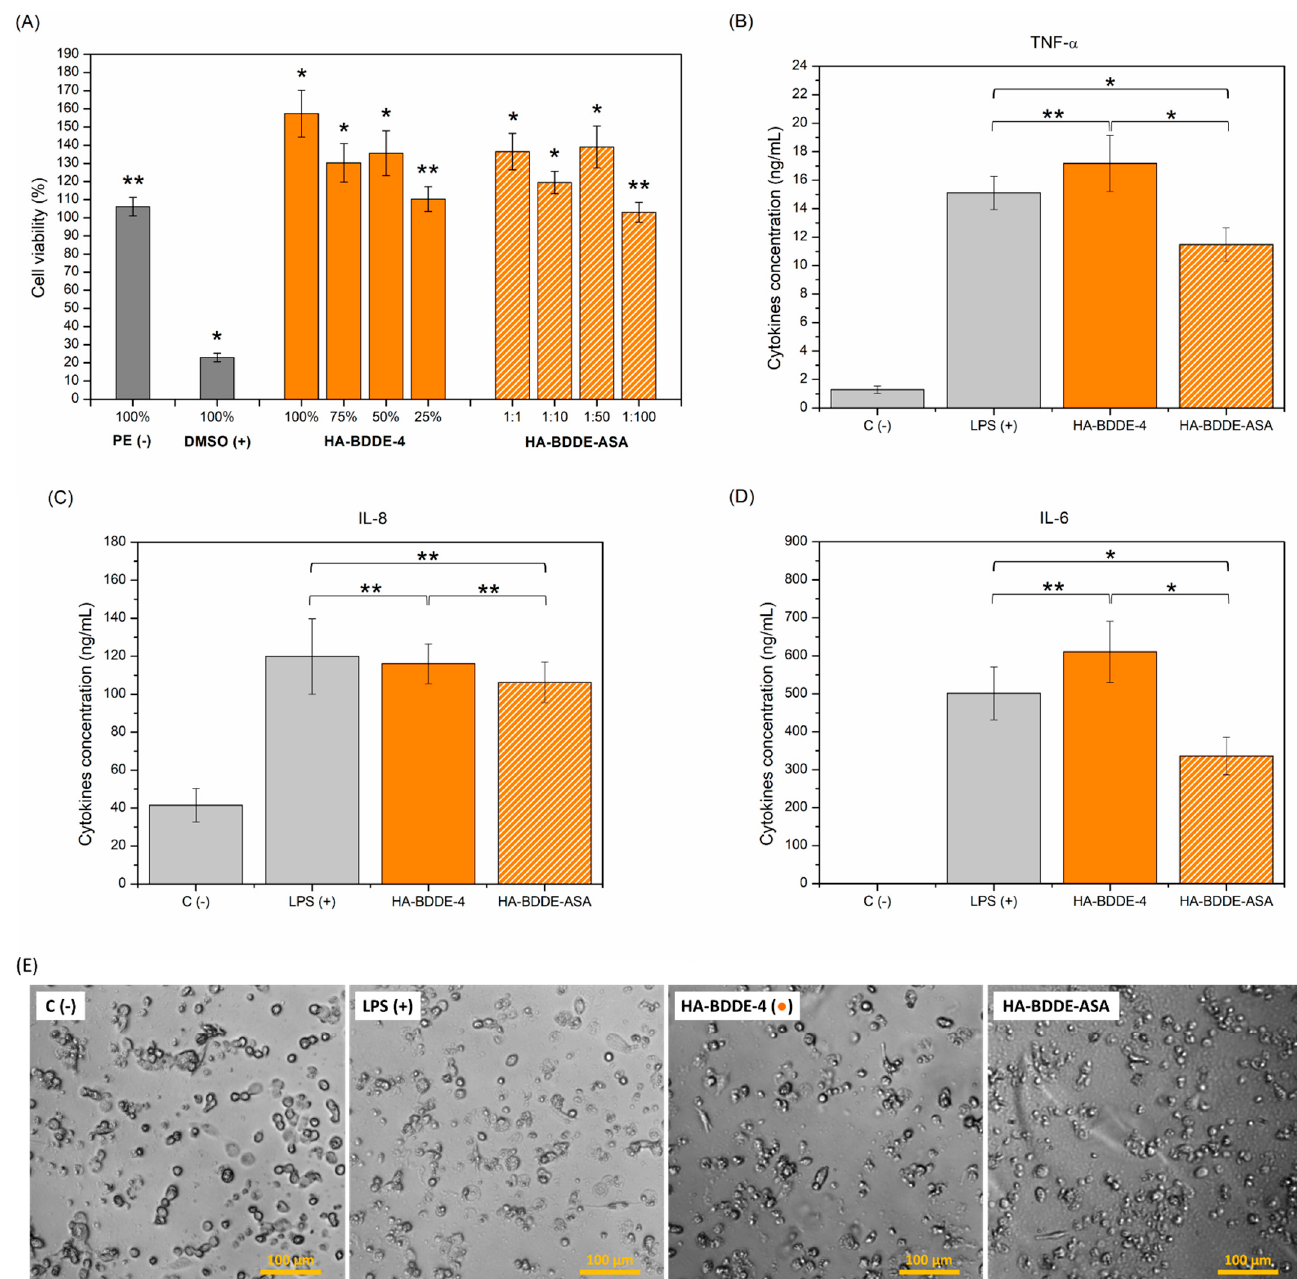
Figure 7. ( A ) THP-1 cell viabilities and ( B ) TNF- α , ( C ) IL-8, and ( D ) IL-6 cytokine levels for controls, HA-BDDE-4, and HA-BDDE-ASA. ( E ) Images of the morphology of the THP-1 cells obtained in the anti-inflammatory assay. * Significant differences ( p < 0.05), ** non-significant differences ( p > 0.05).